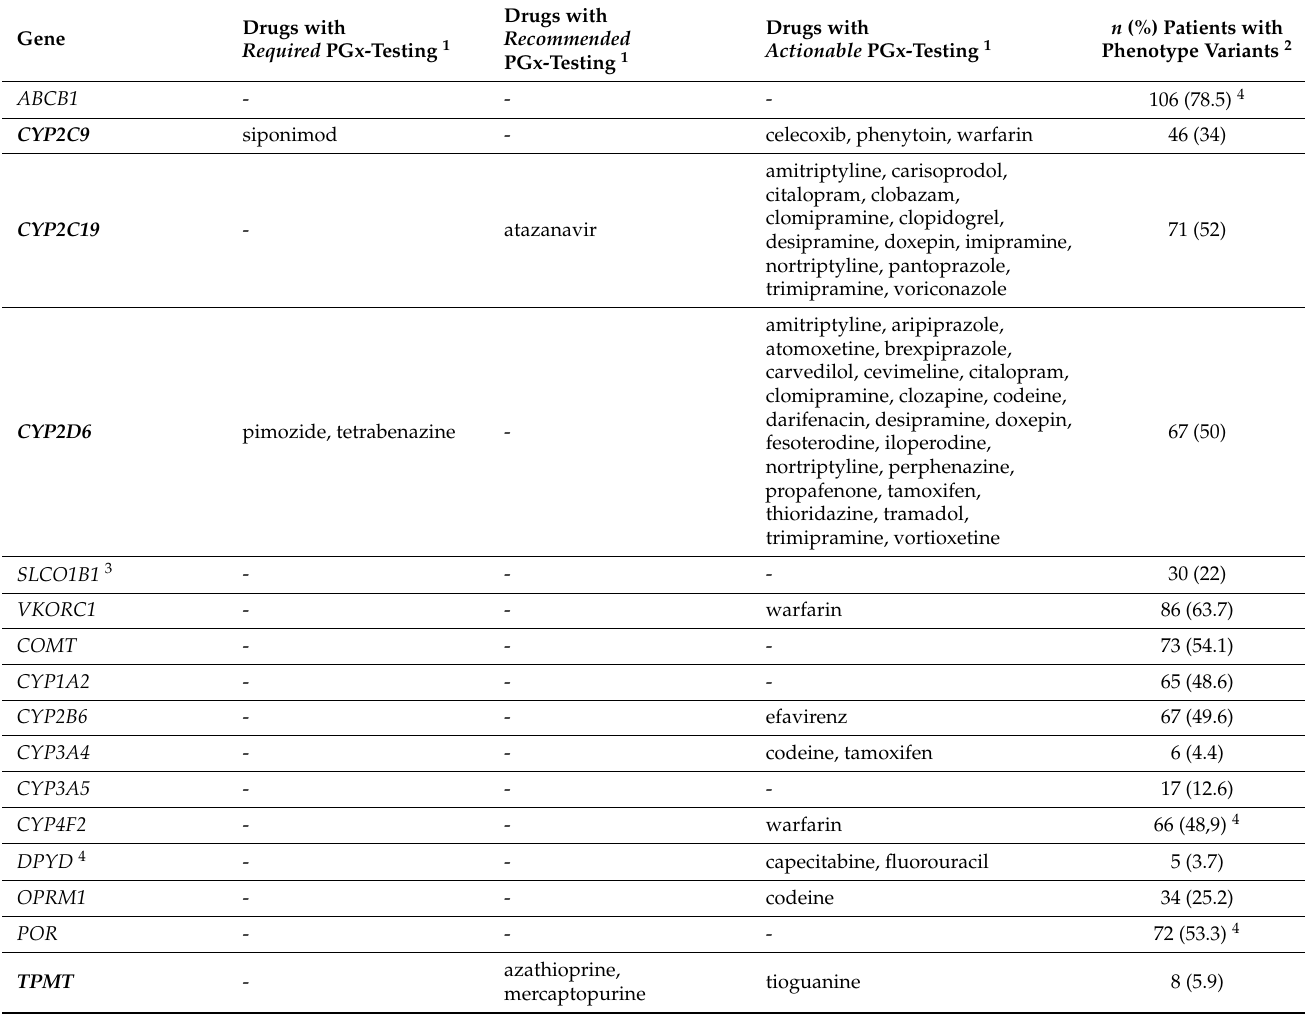
Table 2. Genes tested with SONOGEN panel, PGx levels and detected genetic